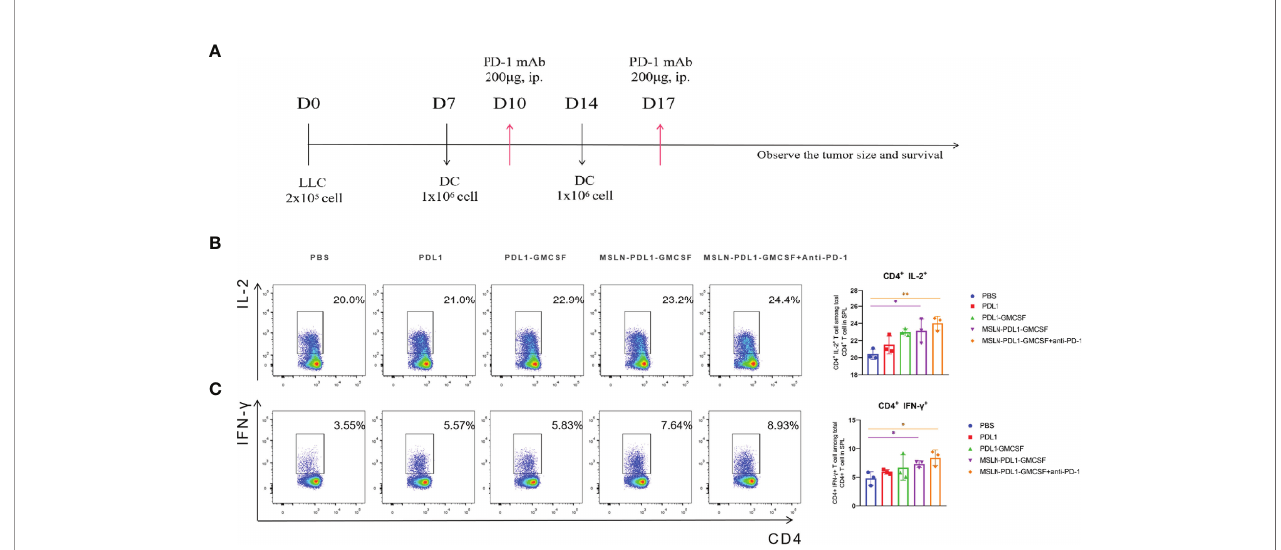
FIGURE 3 | MSLN-PDL1-GMCSF protein vaccine pulsed with DCs increases IFN- g and IL-2 secretion by Th cells. (A) C57BL/6 mice were immunized twice, weekly, with 100 m g/mL of vaccine protein-loaded DCs and PBS-DC control. Splenocytes were isolated for assay 3 days after immunization. (B) The frequency of IL- 2 + production in CD4 + T cells by intracellular staining analysis and fl ow cytometry. (C) Frequency of IFN- g + among CD4 + T cells was analyzed. Mean ± SD (n=3). *p < 0.05, **p < 0.01.